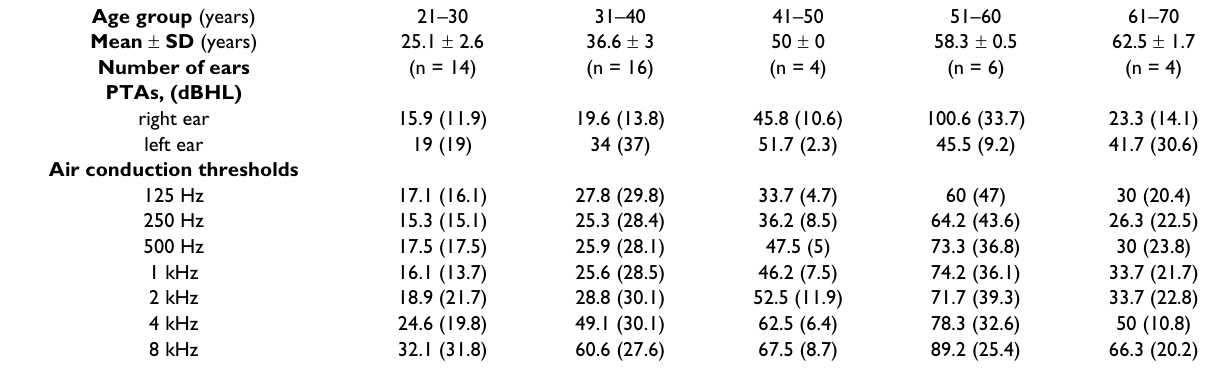
Table 2: Mean pure-tone averages (PTAs) and average air conduction thresholds from 125 Hz to 8 kHz as a function of age for affected individuals. Age group